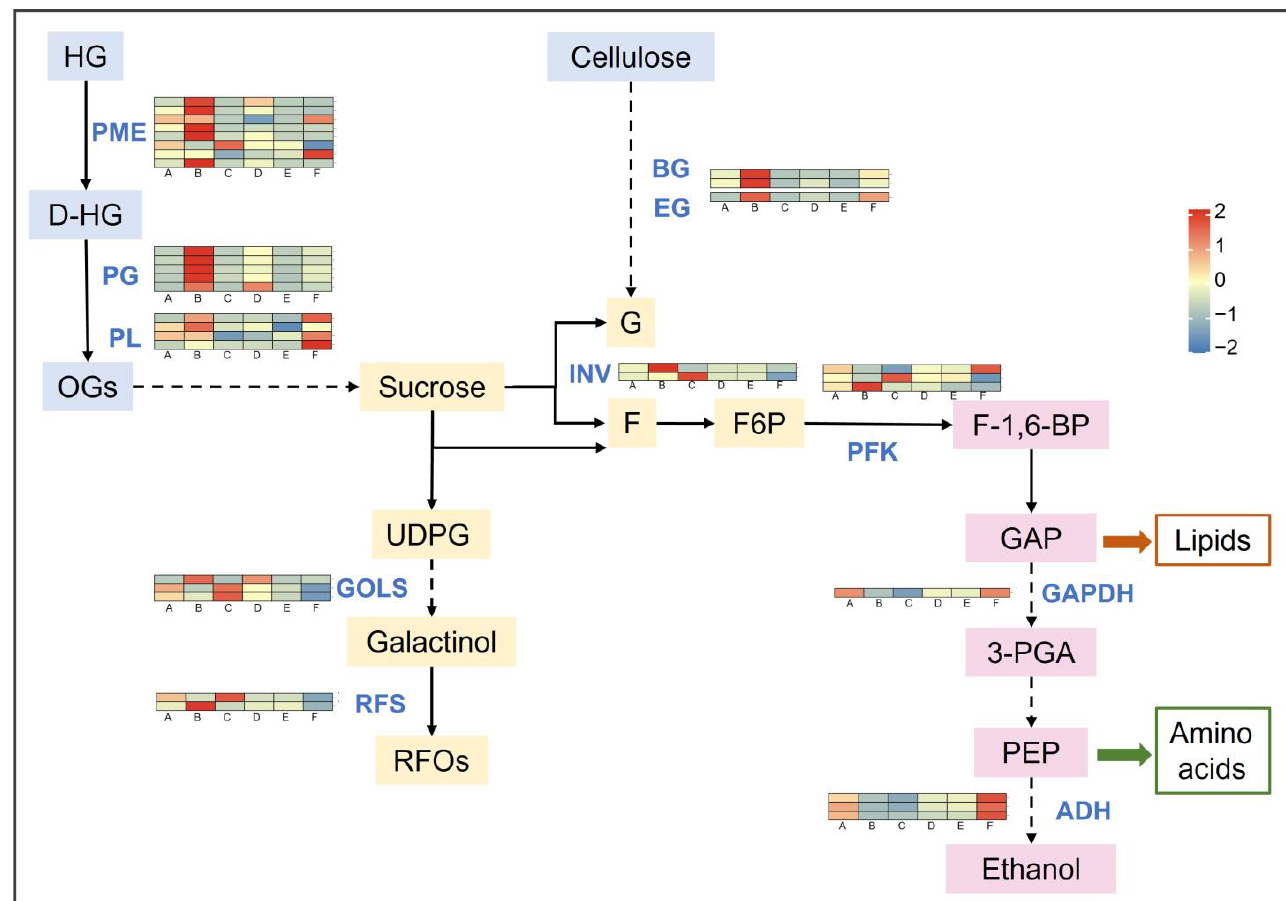
Figure 6. Carbohydrate metabolic pathways in Cabernet Sauvignon plants under freezing stress. Note: The dotted line indicates that there is no direct conversion relationship between the two com-